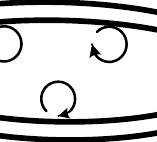
Figure 1. Schematic of Karman Vortex Street.